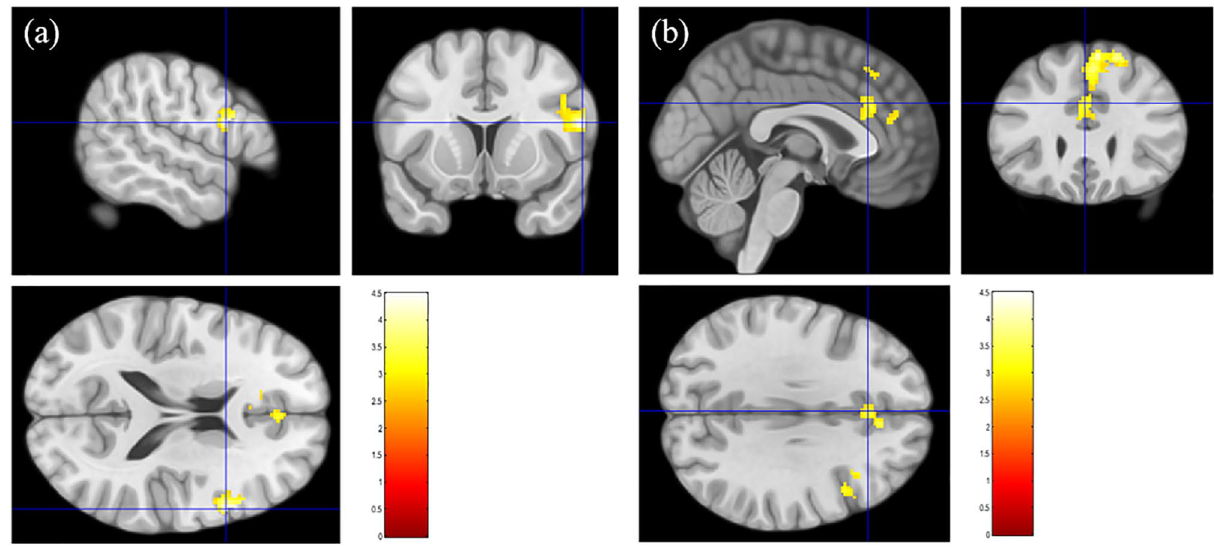
Figure 1. Brain areas showing less activation in response to sleep-related pictures in the insomnia group. Brain regions that showed more activation in good sleepers than insomnia patients in response to sleep-related pictures. Higher levels of brain activation (red and yellow) were observed in the right inferior frontal ( a ) and superior medial frontal ( b ) gyri in the good sleepers (FDR correction; p < 0.05).